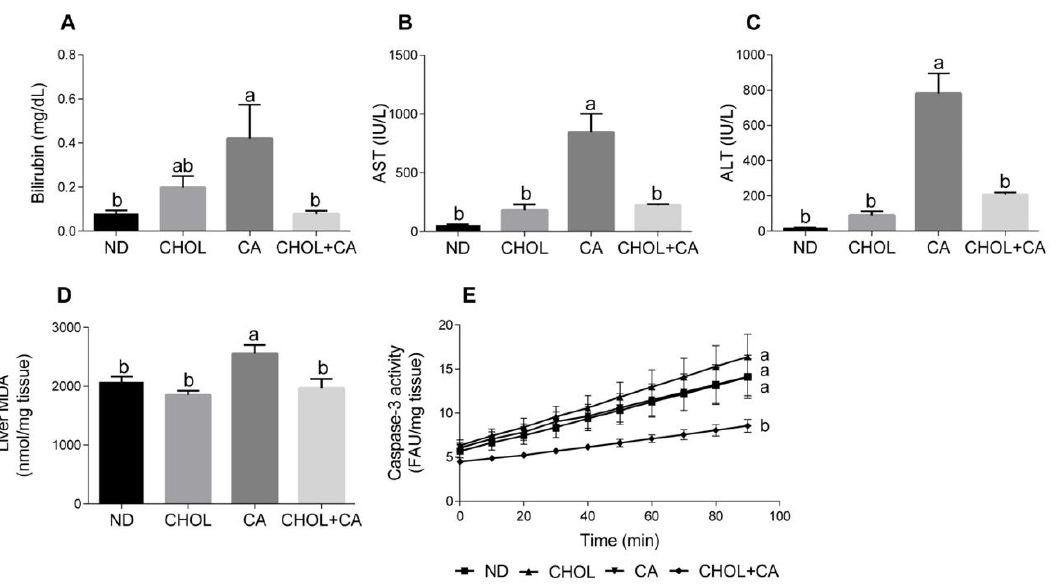
Figure 1. Effect of dietary cholesterol and cholic acid on hepatic damage markers. Male C57BL/6J mice aged four to five weeks were fed: ND — normal diet ( n = 10), CHOL — cholesterol diet ( n = 10), CA — cholic acid diet ( n = 9), CHOL + CA — cholesterol and cholic acid diet ( n = 8) for six weeks. ( A ) Serum bilirubin levels. ( B ) Serum AST levels. ( C ) Serum ALT levels. ( D ) Malondialdehyde (MDA) liver content. ( E ) Liver caspase-3 activity. All values are expressed as mean ± SEM. Columns indicated with different letters (a, b) are significantly different ( p < 0.05) in Tukey-Kramer post-hoc test.